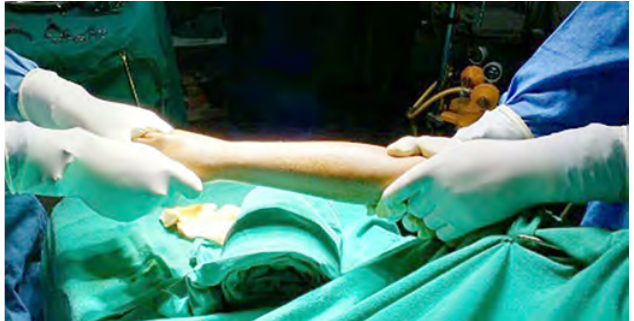
Fig 2 : Closed reduction being done